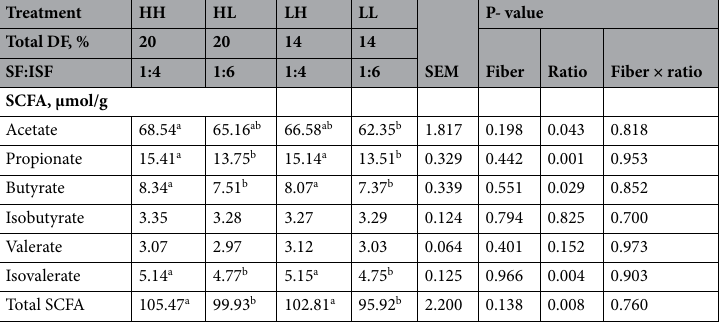
Table 4. Effects of total dietary fiber levels and soluble, insoluble dietary fiber ratio on short-chain fatty acid in feces of sows. SEM standard error of means, SCFA short-chain fatty acid, DF dietary fiber, SF soluble fiber, ISF insoluble fiber. a,b Means with different superscripts within rows are significantly different at (P < 0.05).